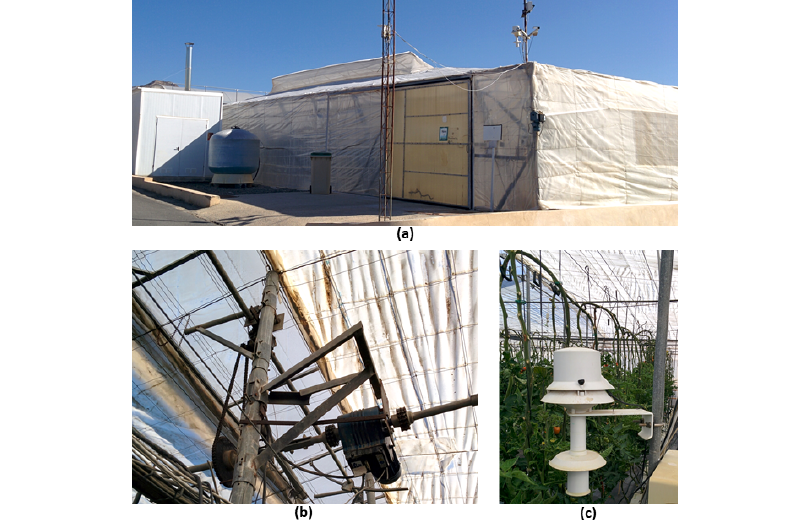
Figure 1. Experimental greenhouse: ( a ) Exterior view in which roof and side vents can be observed. ( b ) Motor for the roof vents. ( c ) Inside air temperature and humidity sensor protected with a solar radiation